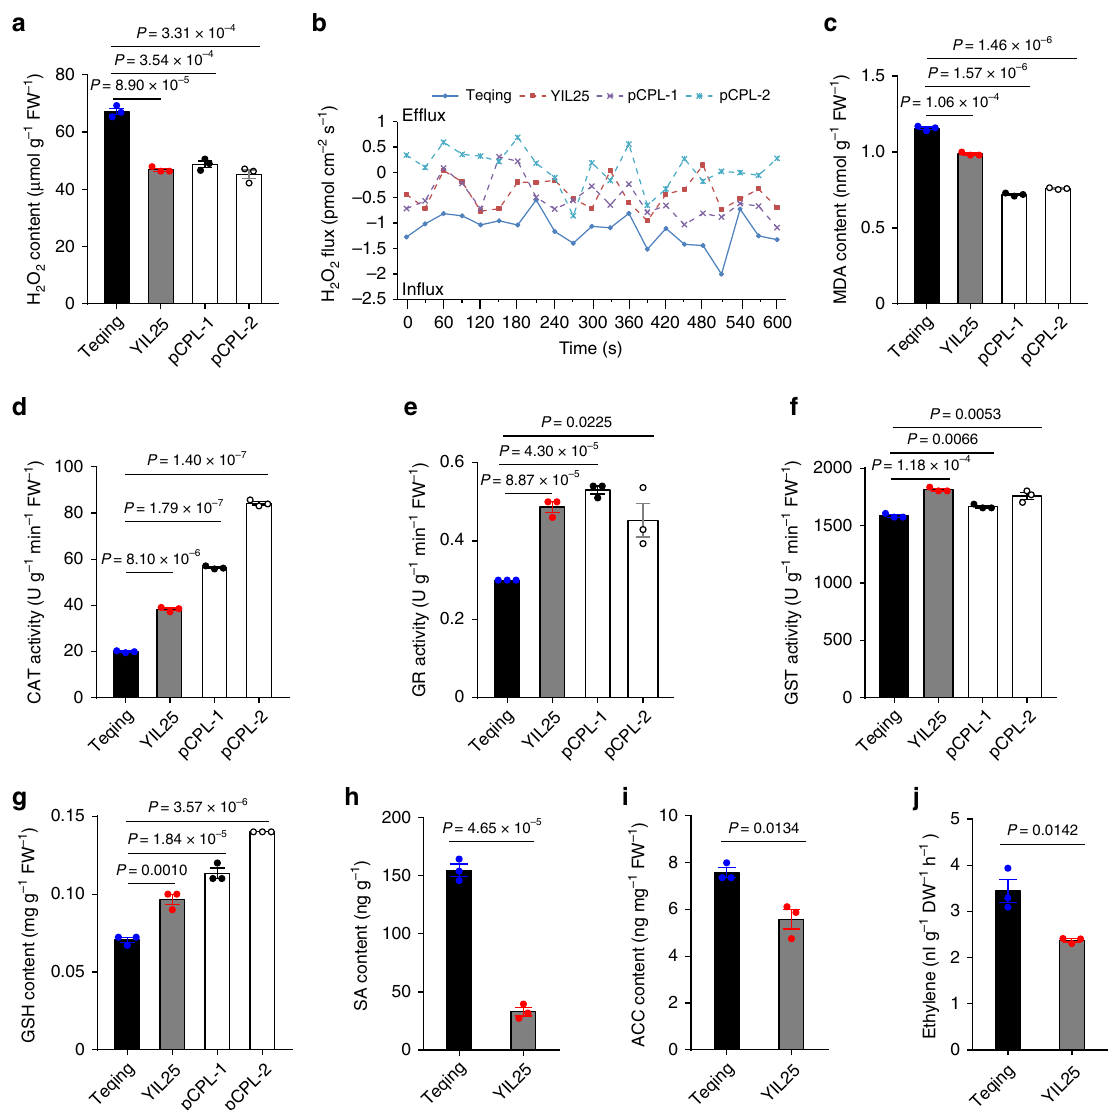
Fig. 6 Physiological and biochemical oxidative stress indices of calli subcultured for 21 days. a H 2 O 2 contents in the two parents and two positive complementation transgenic plants. b H 2 O 2 fl ux ( n = 4). c MDA contents. d – f Assay of antioxidant enzyme activities. CAT, catalase. GR, glutathione reductase. GST, glutathione S-transferase. g Antioxidant GSH contents. h – j Comparison of phytohormone contents between Teqing and YIL25. SA, salicylic acid; ET, ethylene; ACC, 1-aminocyclopropane-1-carboxylic acid, a direct precursor of ET. All values in ( a ) and ( c ) to ( j ) are presented as means ± SE ( n =